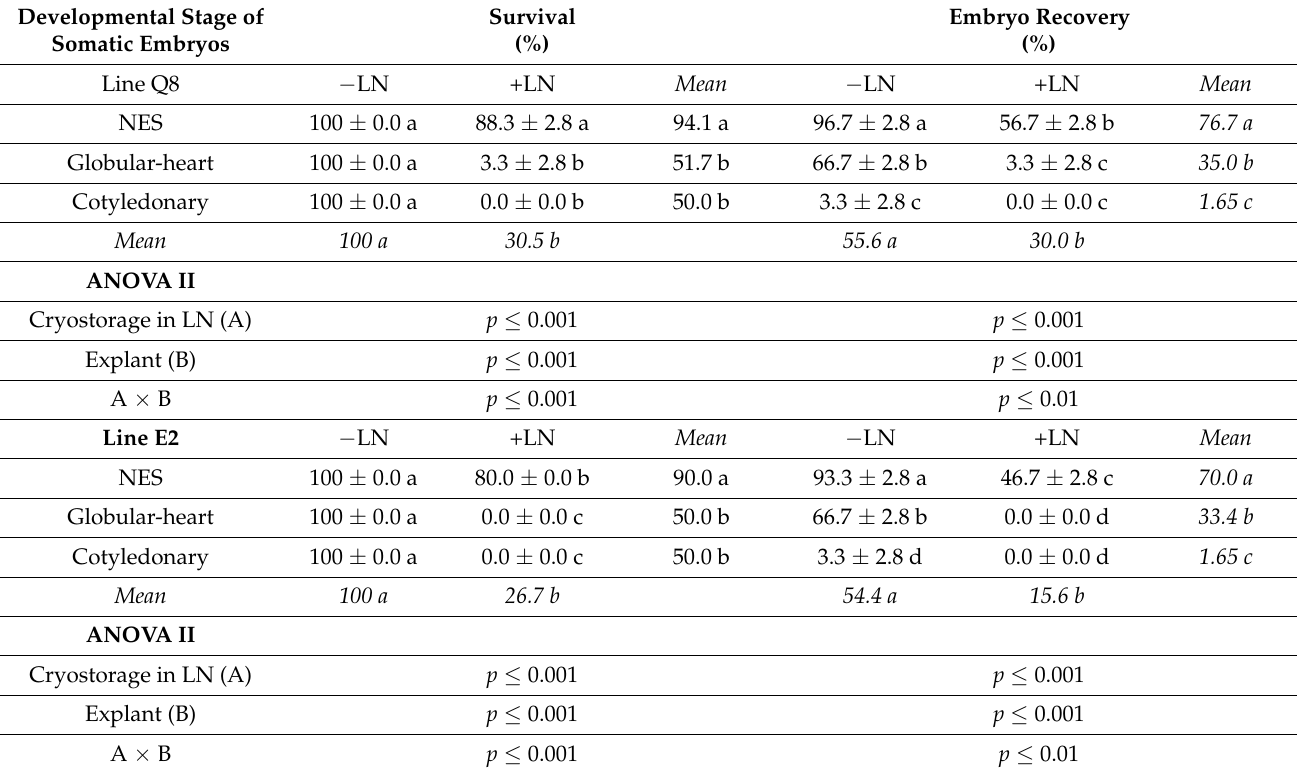
Table 1. Embryo survival (%) and recovery (%) in three different types of explant isolated from two holm oak embryogenic lines after preculture of embryos on medium containing sucrose and incubation in PVS2 solution for 15 min with (+LN) or without ( − LN) and subsequent cryostorage in LN for one